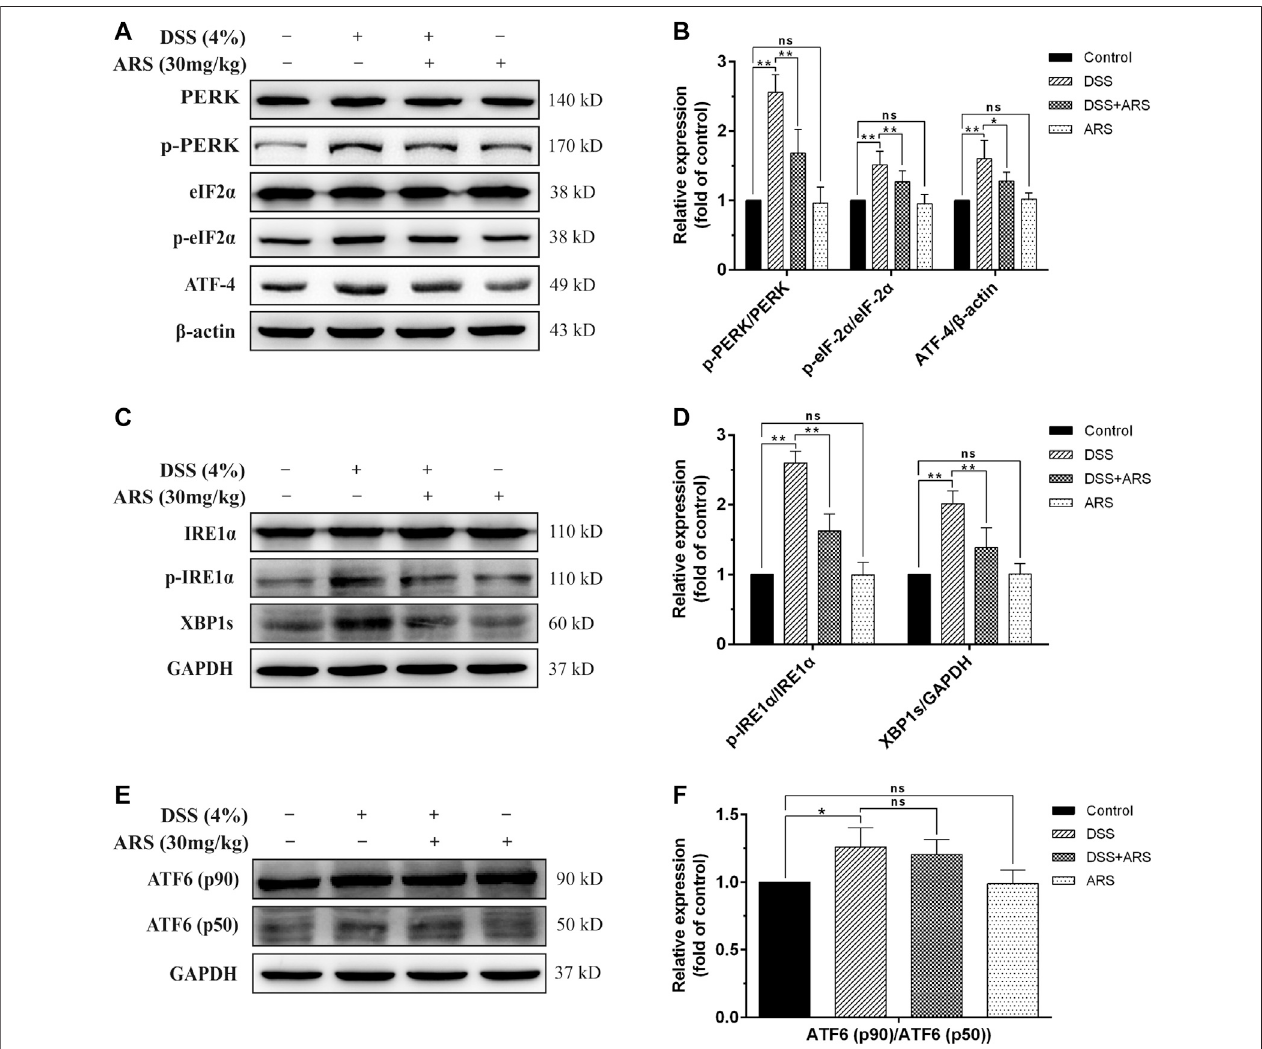
FIGURE 2 | ARS selectively attenuated UPR pathways in DSS-challenged colon tissues. (A) The expression of major proteins in PERK-eIF2 α -ATF4-CHOP signaling pathway. (B) Quanti fi ed results from (A) . (C) The expression of major proteins in IRE1 α -XBP1 signaling pathway. (D) Quanti fi ed results from (C) . (E) The expression of ATF6 was analysis by western blot. (F) Quanti fi ed results from (E) . Data are presented as mean ± SD ( n (cid:1) 3). * p < 0.05, ** p < 0.01.